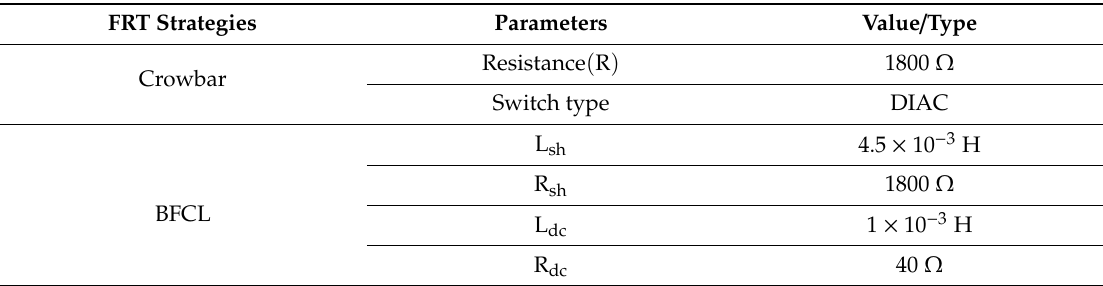
Table A3. FRT strategies